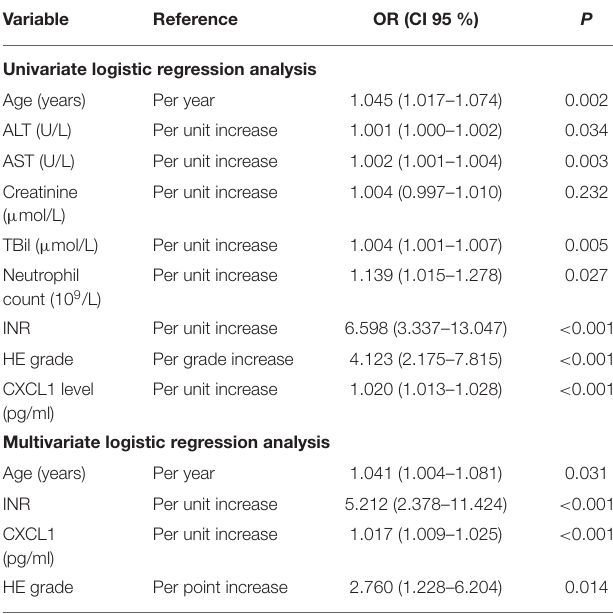
TABLE 2 | Associations of clinical parameters and prognostic scoring systems with serum CXCL1 level in patients with HBV-ACLF. Variable